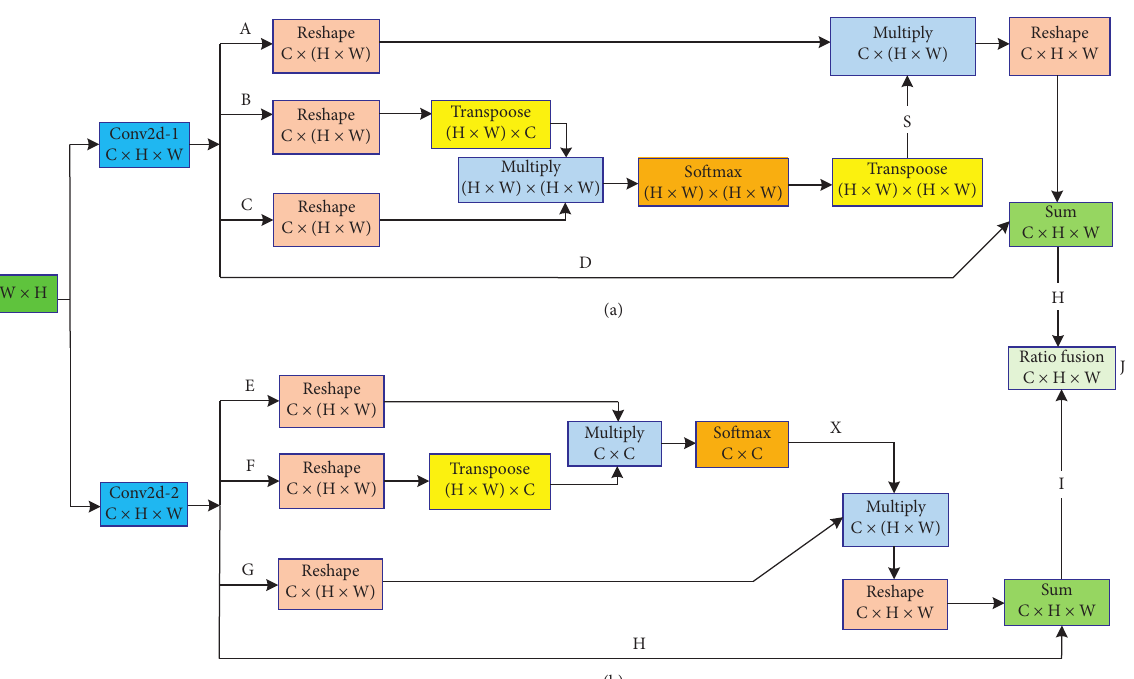
Figure 6: Out block.